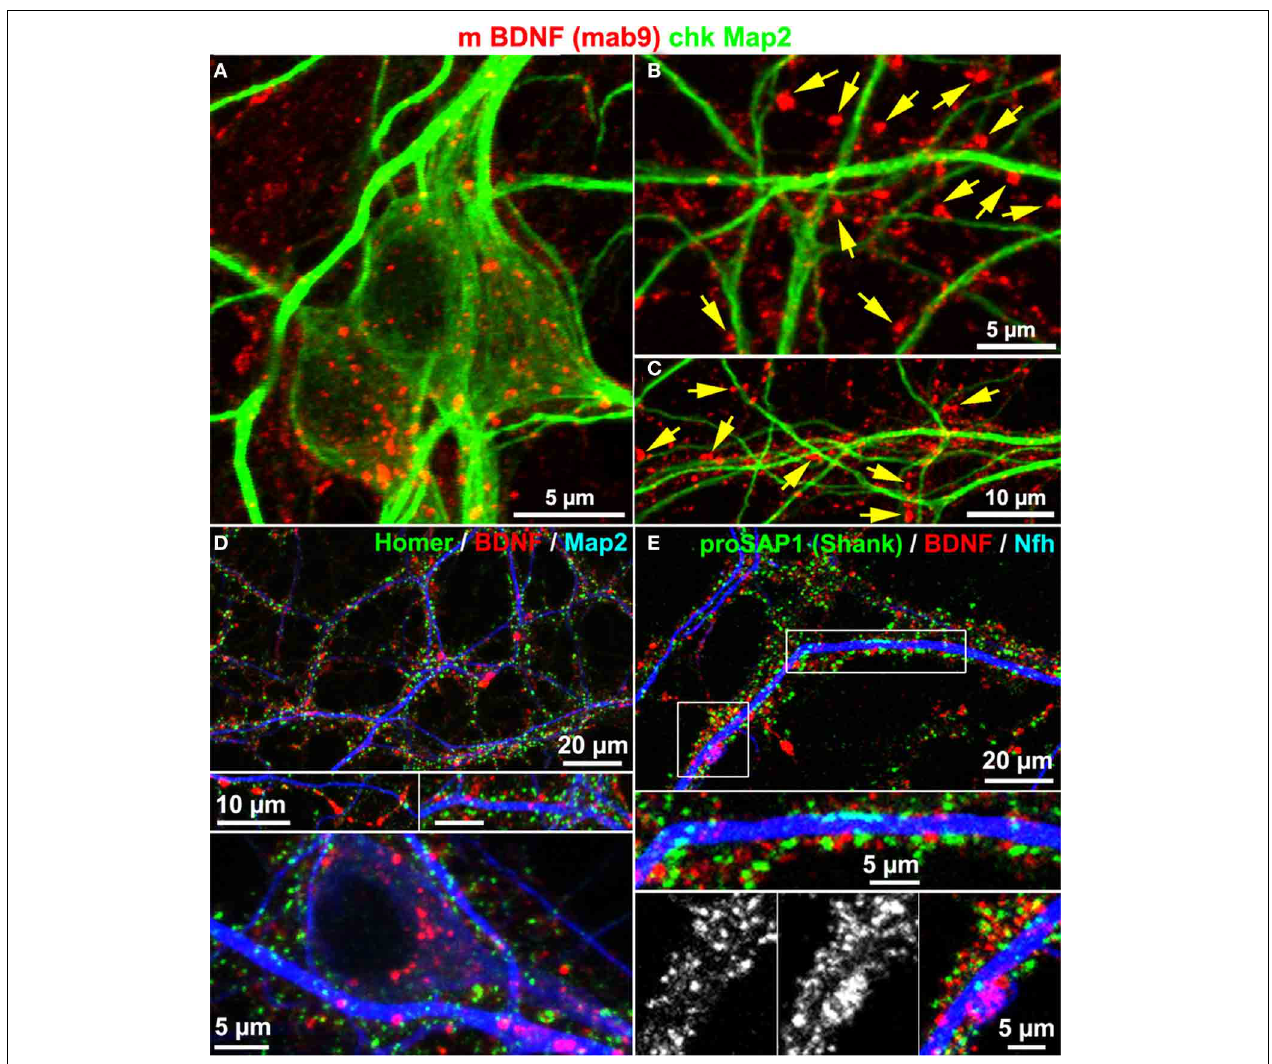
FIGURE 4 | BDNF immunoreactivity is low in Map2 + neurites. (A) Map2 and BDNF IR overlapped at somata. (B–C) Peripheral synapse-like BDNF labels (yellow arrows) were Map2-negative (DIV 22). (D,E) In